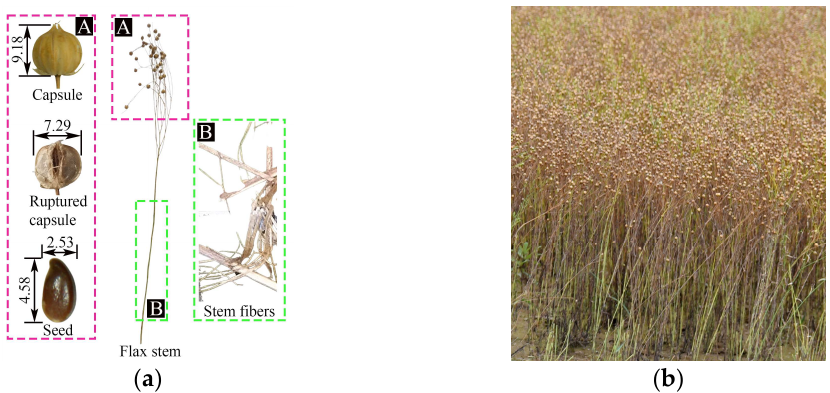
Figure 1. Flax plant structure and cultivation status: ( a ) flax plant structure; ( b ) status of flax cultivation, A: Flax capsule; B: Flax stem.